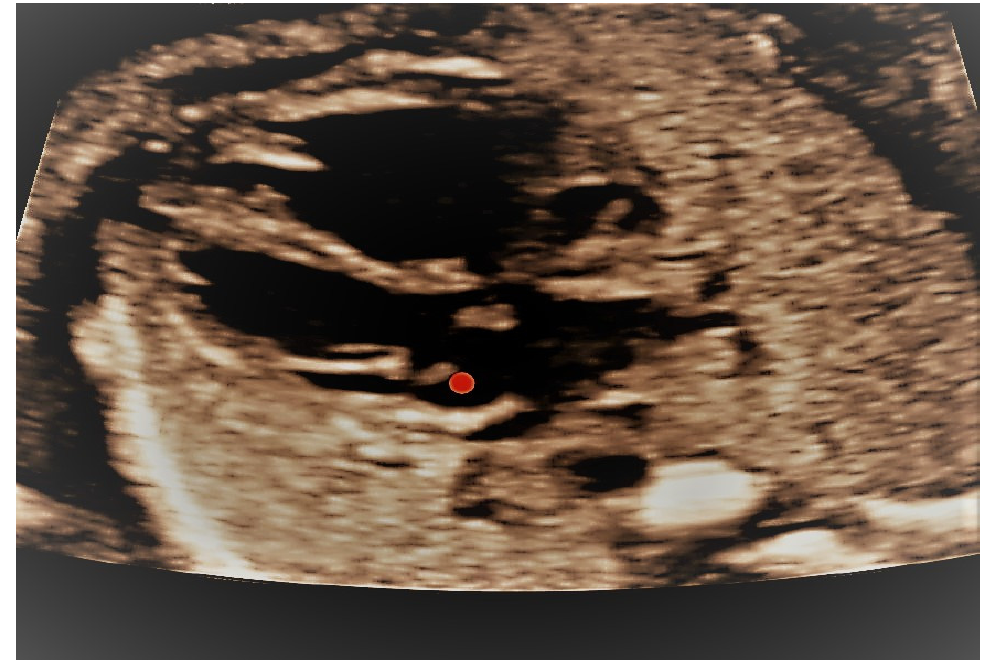
Figure 5. Transversal section at the TTVV level; absence of the right SVC. PLSVC—persistent left